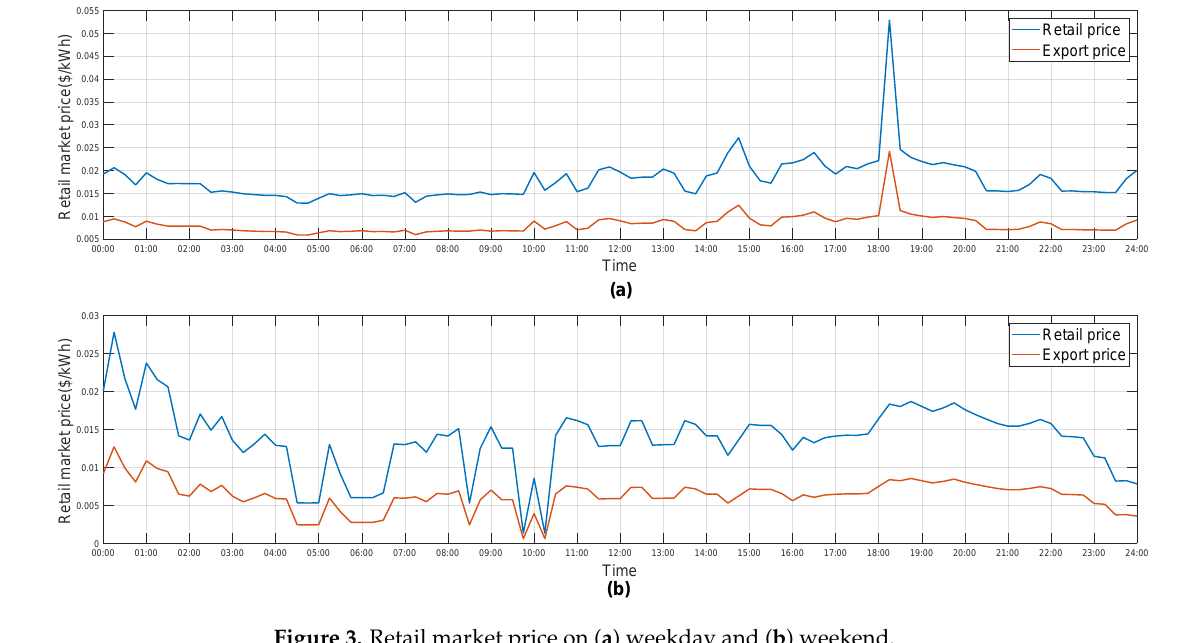
Figure 3. Retail market price on ( a ) weekday and ( b ) weekend. Table 1. Comparison of average clearing prices and success